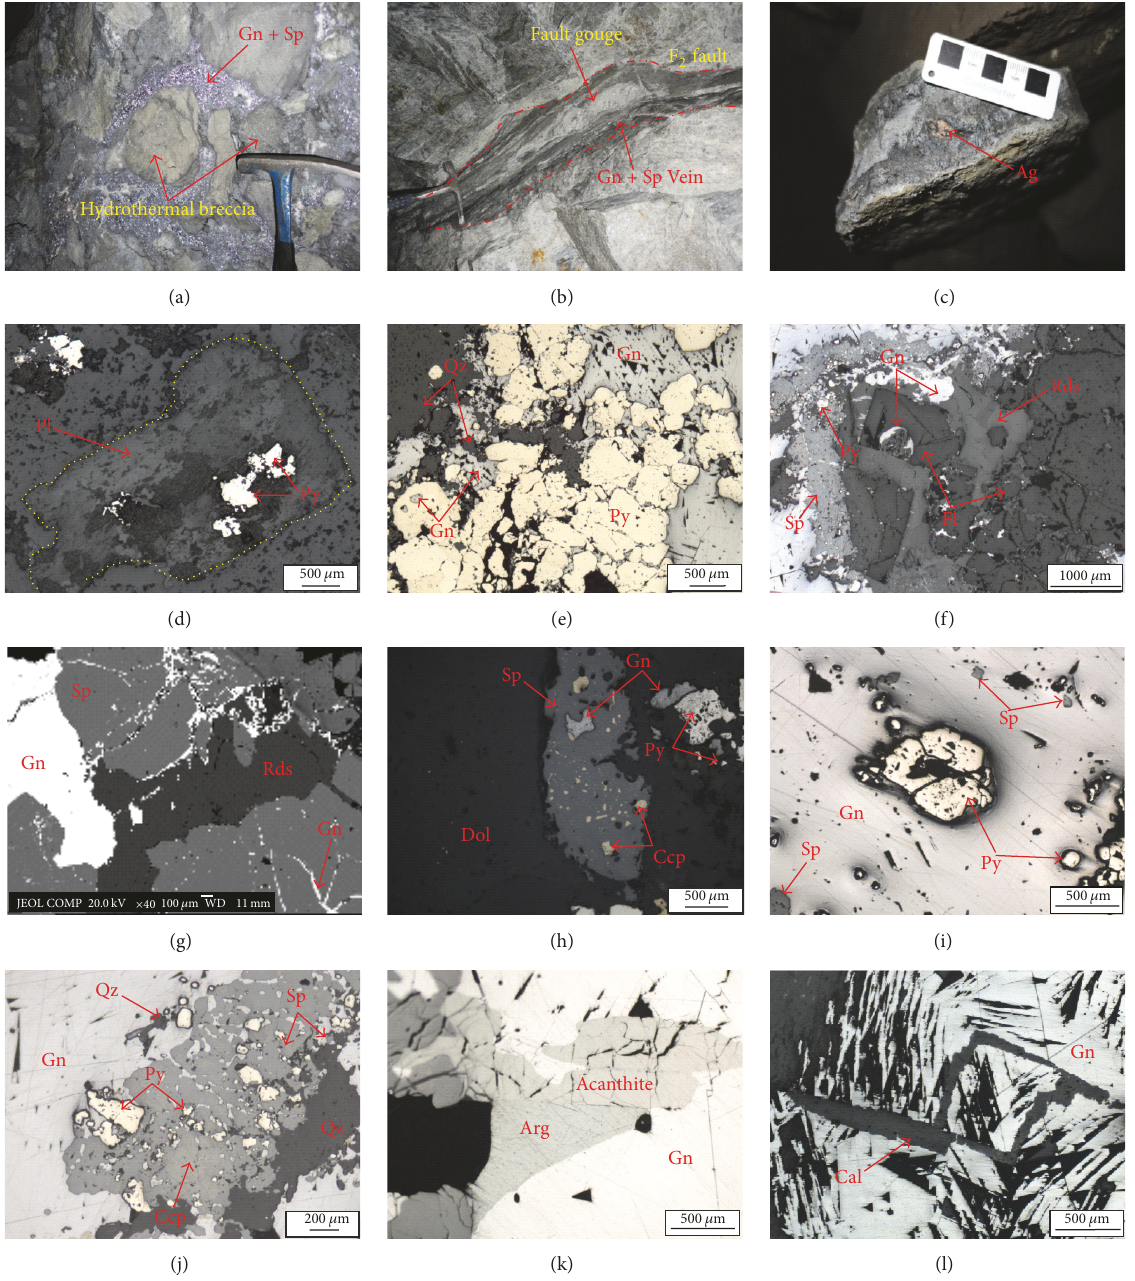
Figure 4: Photographs of hand specimens, photomicrographs, and back-scatter election (BSE) images showing ore fabrics and mineral assemblages of the Zhijiadi deposit. (a) Galena and sphalerite filling in hydrothermal breccia. (b) Galena and sphalerite occurring as vein in near F 2 fault zone. (c) Native silver in the gangue minerals. (d) Pyrite disseminated in plagioclase phenocryst of quartz porphyry. (e) The early stage quartz and pyrite replaced by galena. (f) Euhedral-subhedral fluorite replaced by rhodochrosite. (g) Coexistence of sphalerite and rhodochrosite in the main stage and replaced by galena (BSE). (h) Chalcopyrite as emulsion droplet within sphalerite, making an exsolution texture. (i) Euhedral-subhedral pyrite replaced by galena. (j) Galena intergrowth with sphalerite in the main stage. (k) Argentite and acanthite intergrow with galena. (l) Corrugation structure in galena caused by the stress effect. Py, pyrite; Gn, galena; Sp, sphalerite; Ccp, chalcopyrite; Arg, argentite; Qz, quartz; Rds, rhodochrosite; Fl, fluorite; Cal, calcite; Pl, plagioclase; Dol,